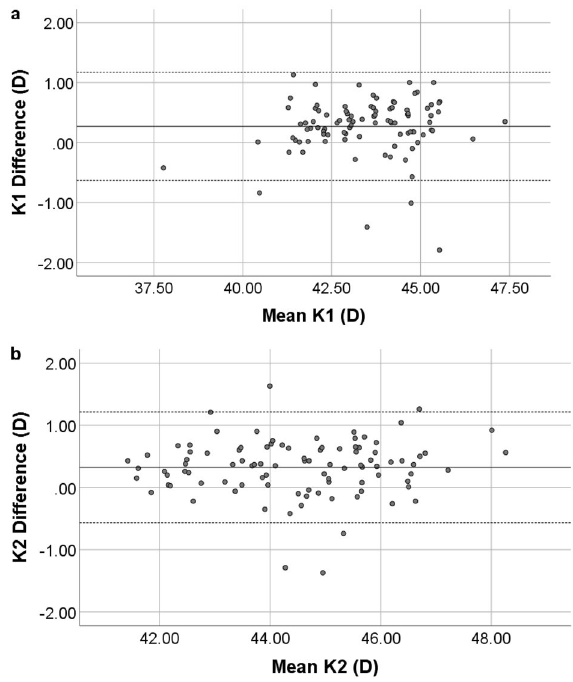
Figure 2. Bland–Altman plot of K1 ( a ) and K2 ( b ) from GALILEI G6 and ANTERION. The solid line represents the mean difference, while the dotted lines on each side show the upper and lower 95% LoA. The K1 and K2 plot demonstrate that only four and five eyes respectively of the total 96 eyes were out of the 95% LoAs, indicating excellent K1 and K2 measurement agreement between the two devices. Created by SPSS (Version 22, SPSS Inc., IBM, Chicago,